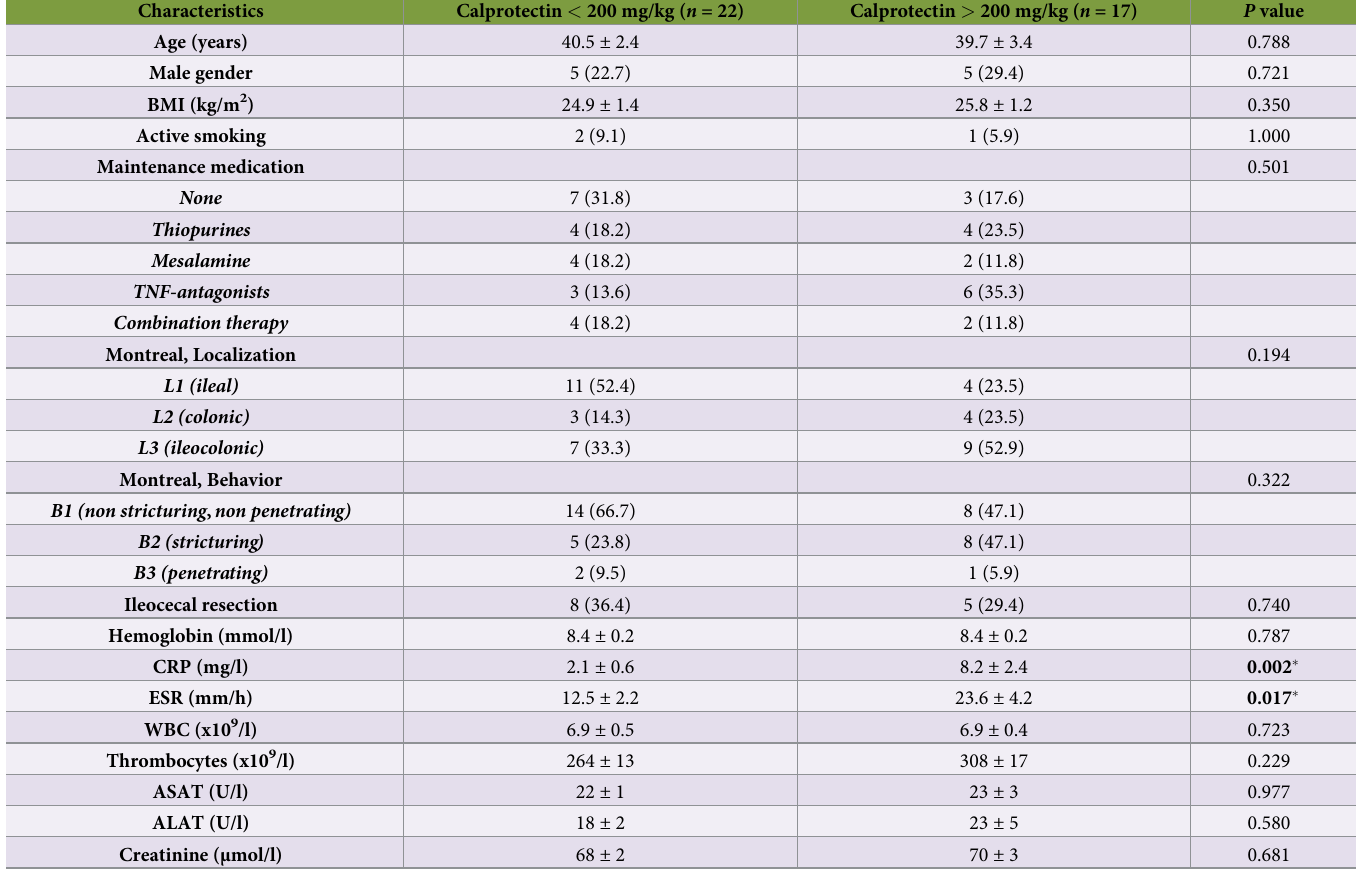
Table 1. Study population characteristics ( n = 39) of Crohn’s disease patients with ‘normal’ ( < 200 mg/kg) and increased ( > 200 mg/kg) fecal calprotectin levels. Characteristics